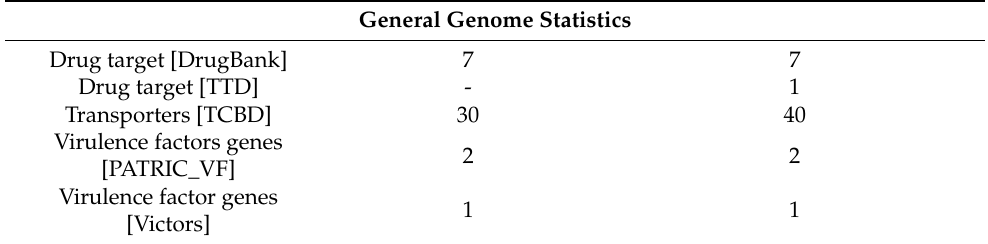
Databases used for gene analysis are indicated in square brackets; CDS — coding sequences; EC — enzyme commission; GO — gene ontology.